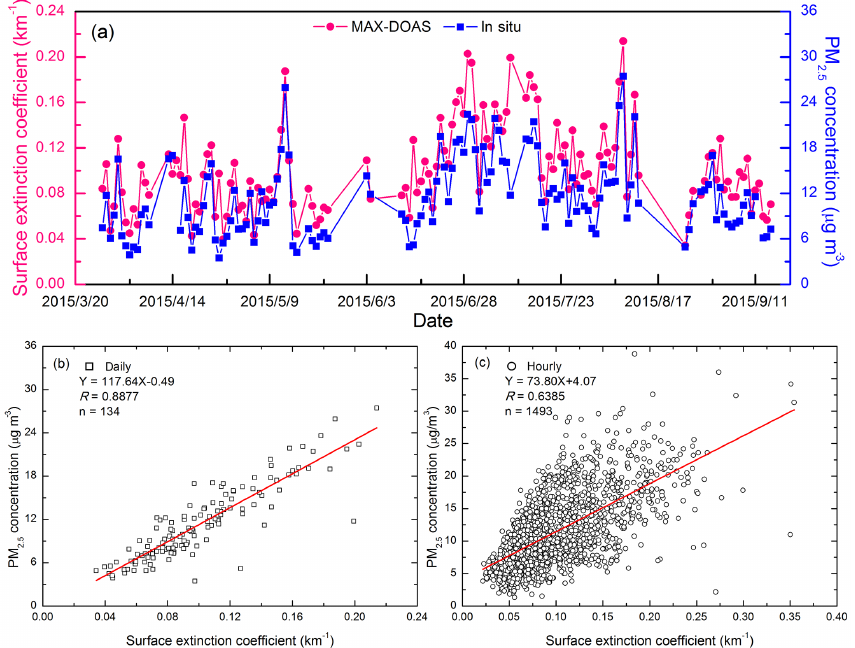
Figure 6. Time series of surface aerosol extinction coefficient retrieved from MAX-DOAS and comparison with in situ PM 2 . 5 concentra- tion (a) . Linear regression plots of daily and hourly data are shown in (b) and (c) , respectively.